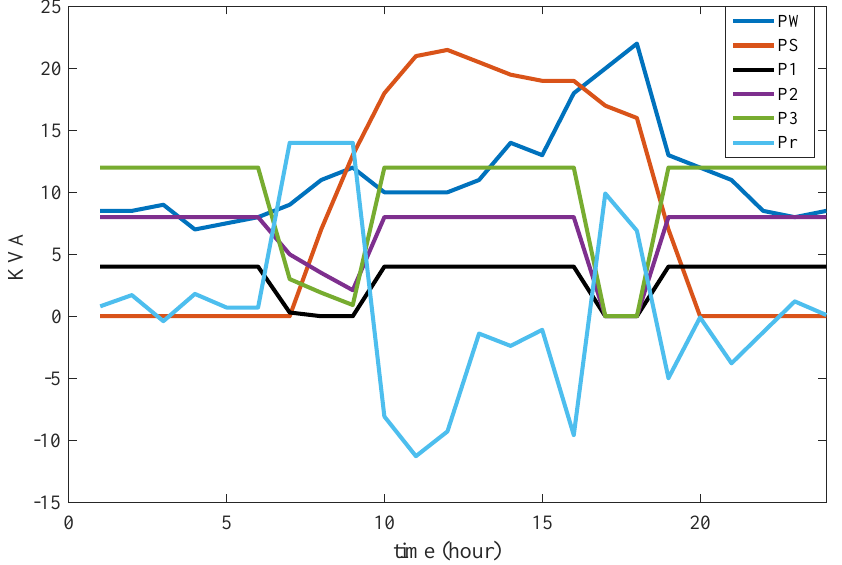
Figure 2. Dispatch of each generator.